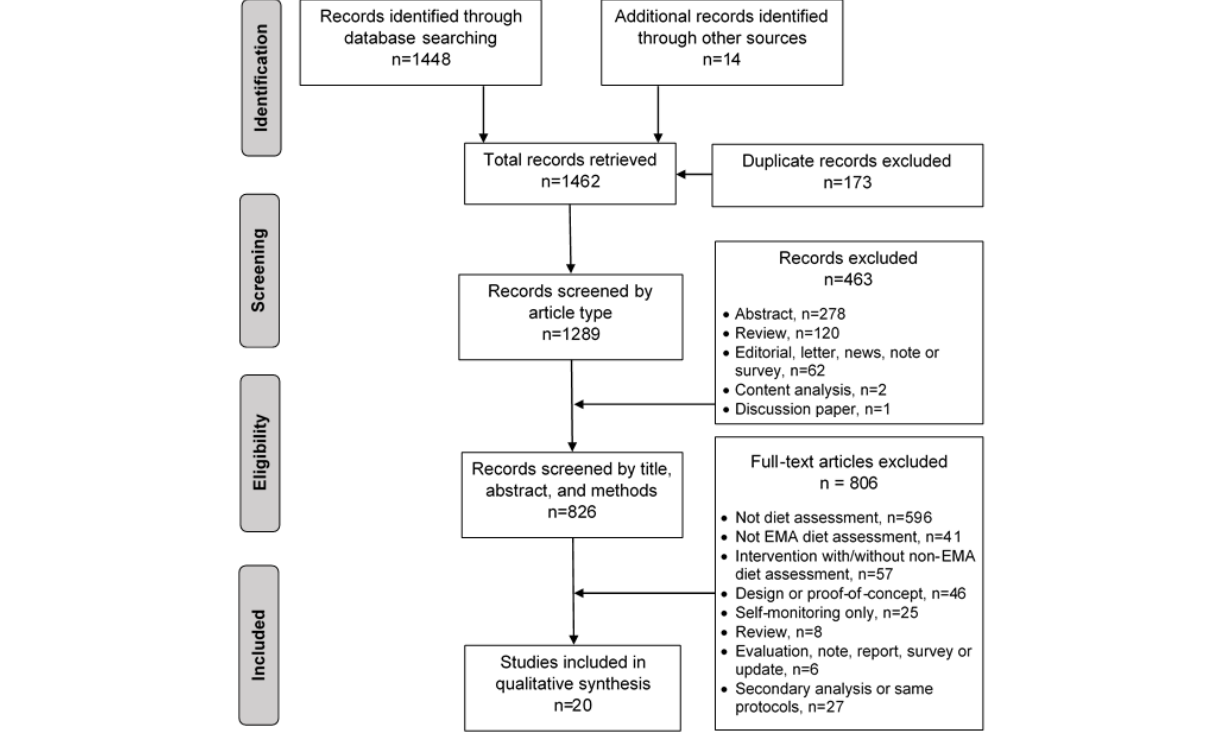
Figure 1. Preferred Reporting of Systematic Reviews and Meta-Analyses diagram. EMA: ecological momentary